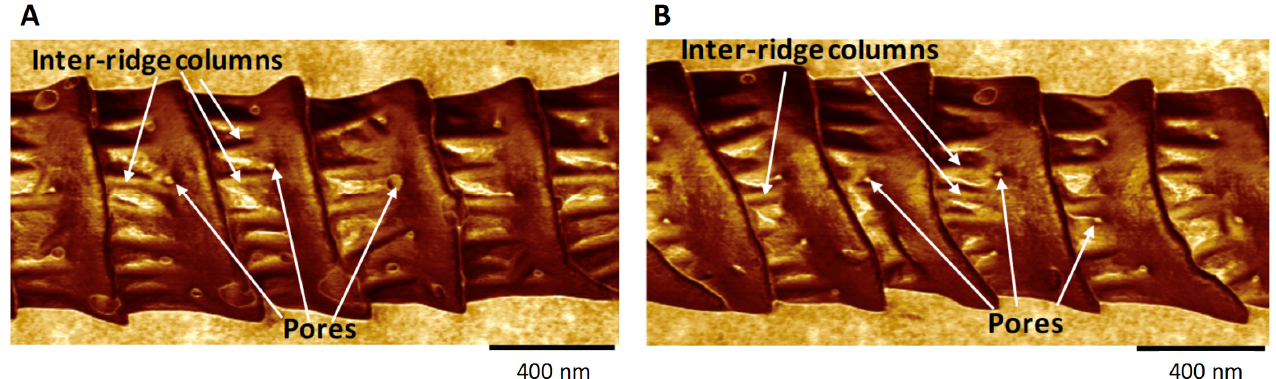
Figure 4. AFM adhesion mode 2D images of the trichoid sensilla from Ostrinia nubilalis E -strain ( A ) and Z -strain ( B ), highlighting the unusual inter-ridge columns typical of this species but missing in all the other species used in this study. A few of the many inter-ridge columns are indicated by white arrows from the top, and locations of some pores are denoted by white arrows from the bottom.